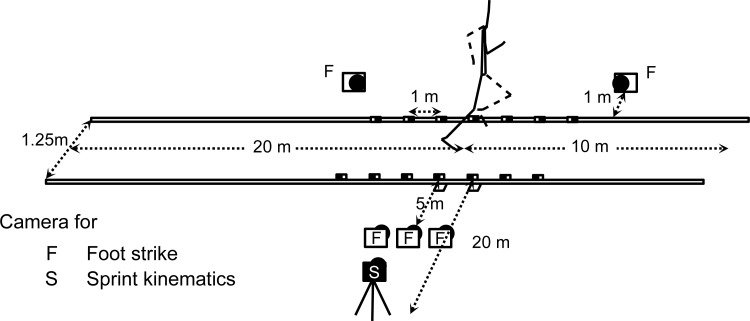
Experimental setup.